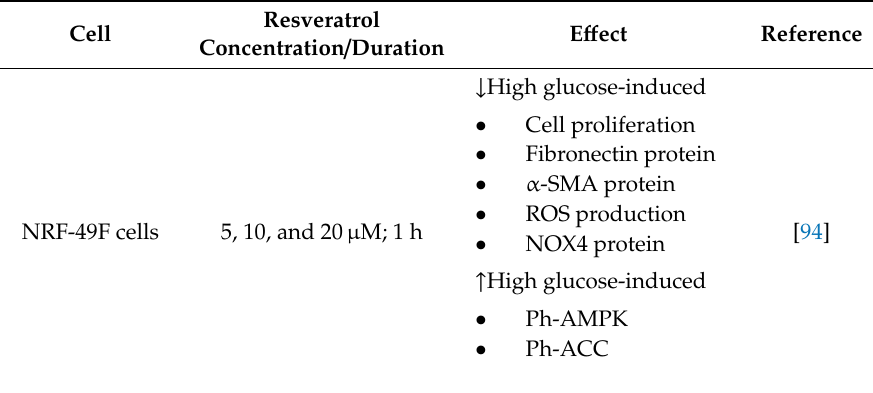
Table 5. E ff ects of resveratrol on kidney